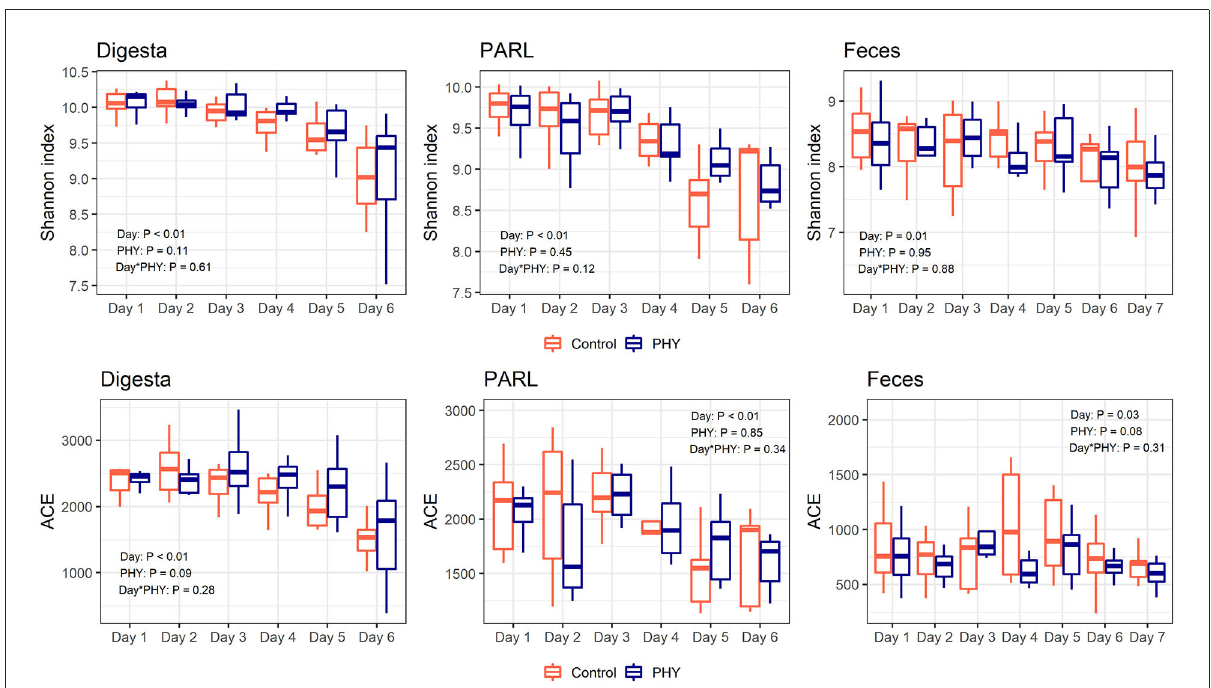
FIGURE1 Alpha-diversity indices in the three analyzed matrices, for control and treatment (PHY) groups. Digesta, solid digesta; PARL, particle associated rumen liquid; ACE, Abundance-based Coverage Estimator. Samples were collected for six consecutive days for rumen content and for an additional seventh day for feces. P -values are presented for the effect of day, phytogenic treatment (PHY) and the day × treatment interaction (Day *